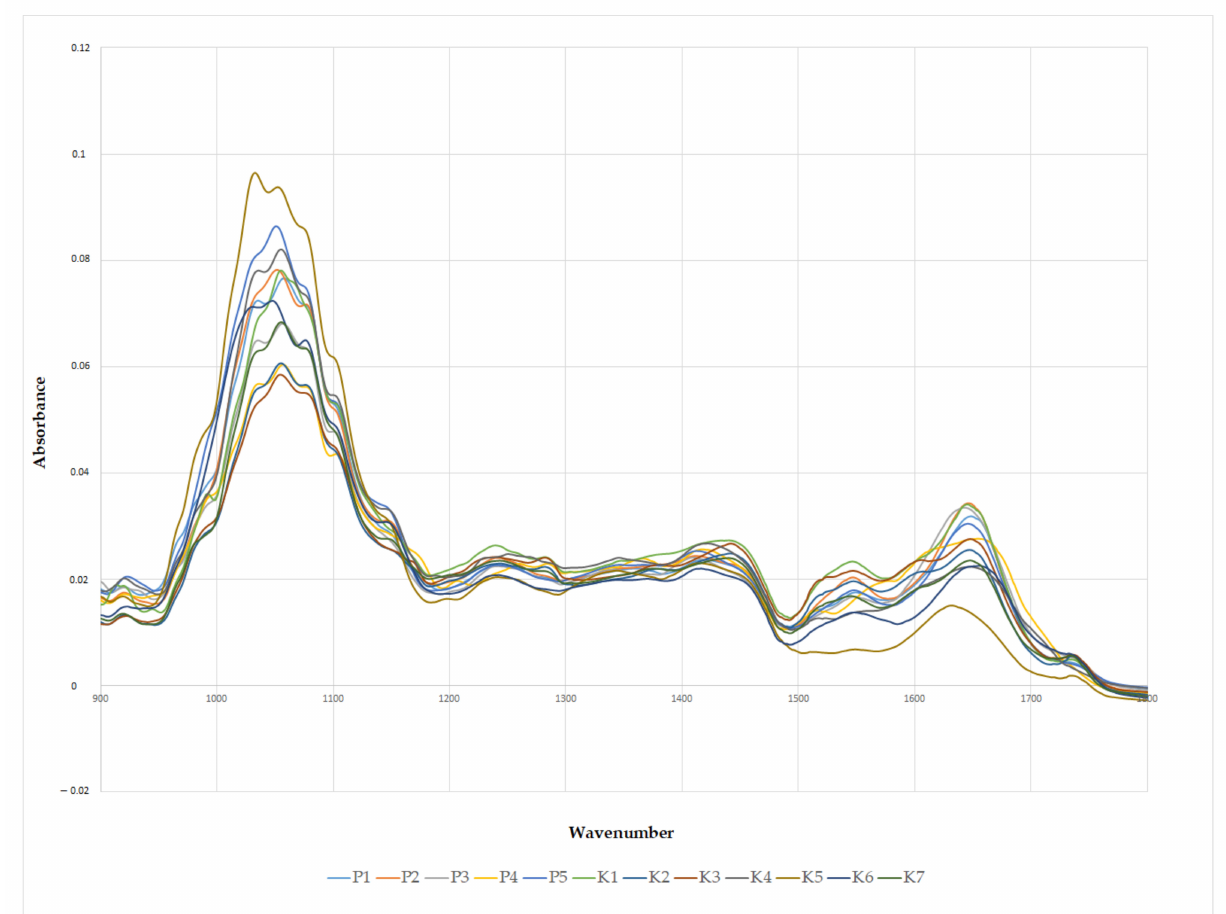
Figure 3. ATR–FTIR spectra of bee pollen samples (K1–K7; P1–P5) in the range of 1800–900cm − 1